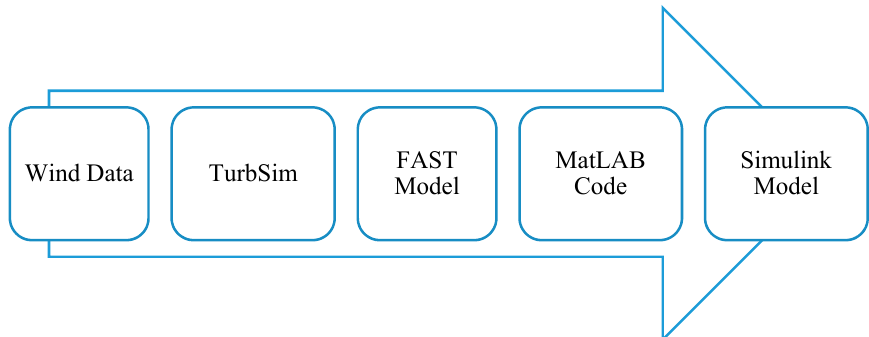
Figure 3. The integration process of the stand-alone software tools.